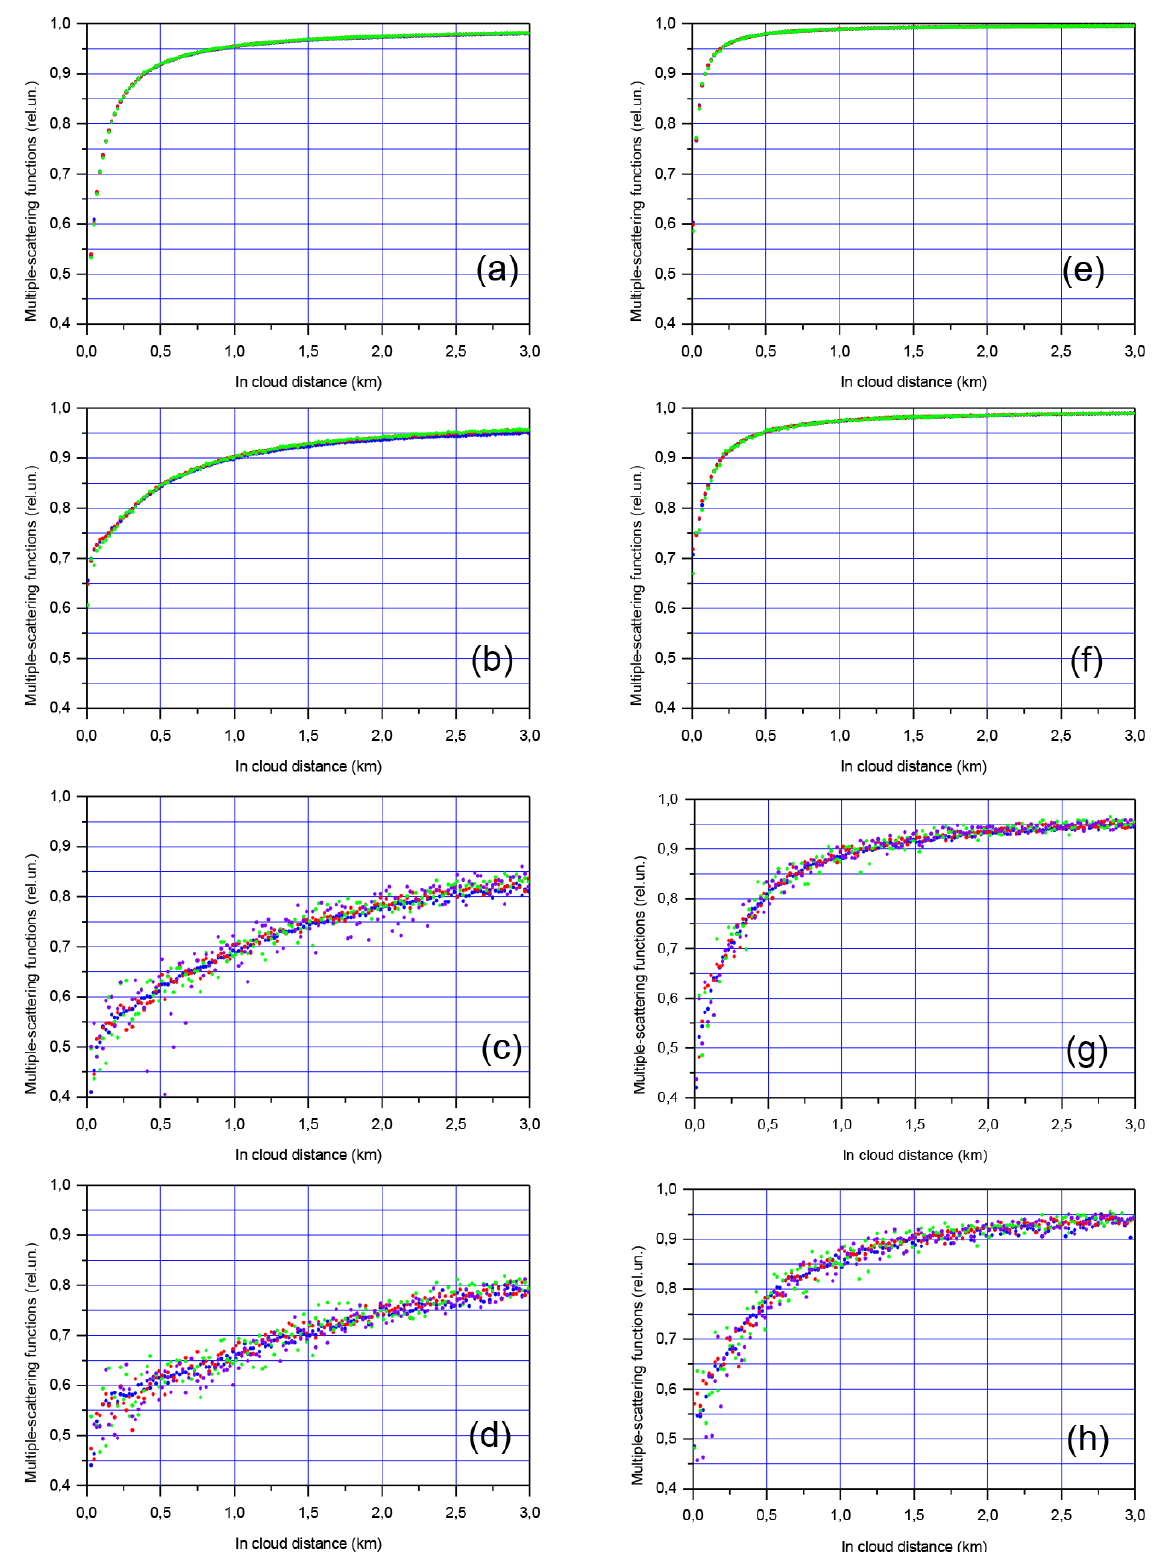
Figure 4. MC simulations of multiple-scattering functions η MS (d) . The full RFOV is 1.0mrad (a–d) and 0.25mrad (e–h) . Coarse aerosol (a, e) , water cloud (b, f) , JS cirrus (c, g) , Ci cirrus (d, h) . The extinction coefficient is 1.0km − 1 (blue points), 0.5km − 1 (red points), 0.2km − 1 (green points), and 0.06km − 1 (purple points). The distance to the cloud base is